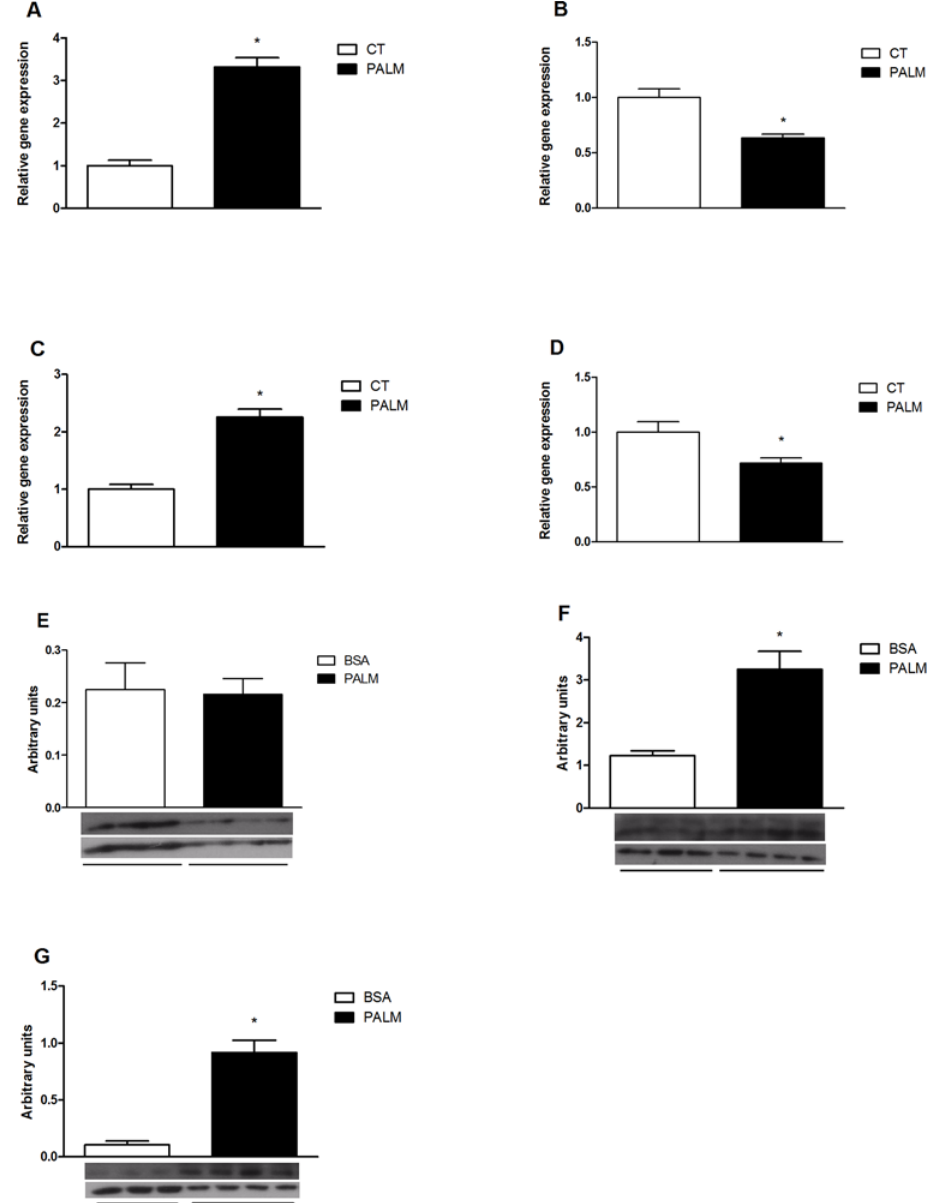
Fig 9. Effect of treatment with conditioned medium on hypothalamic neuron cell lien. A, B, C and D. QRT-PCR was used to analyze the gene expression of TNF, Map1lc3, Sqstm1, Becn1, respectively. E . Western-blotting shows the Beclin-1, LC3-II and p62 to β -actin ratio, respectively in CLU-189 cell line treated with conditioned medium of microglia cells BV-2 treated with 500 μ M of palmitic acid for 6 hours. Values are shown as mean ± SEM. * P <